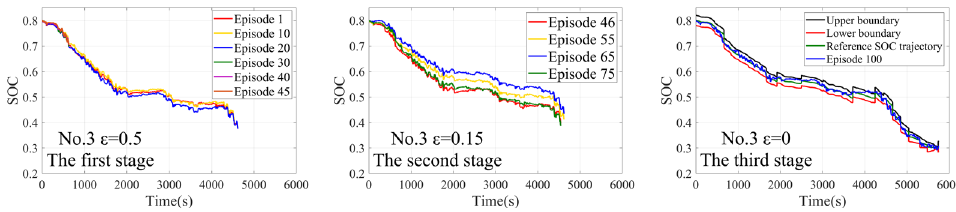
Figure 12. The training process of combined driving cycle 3.